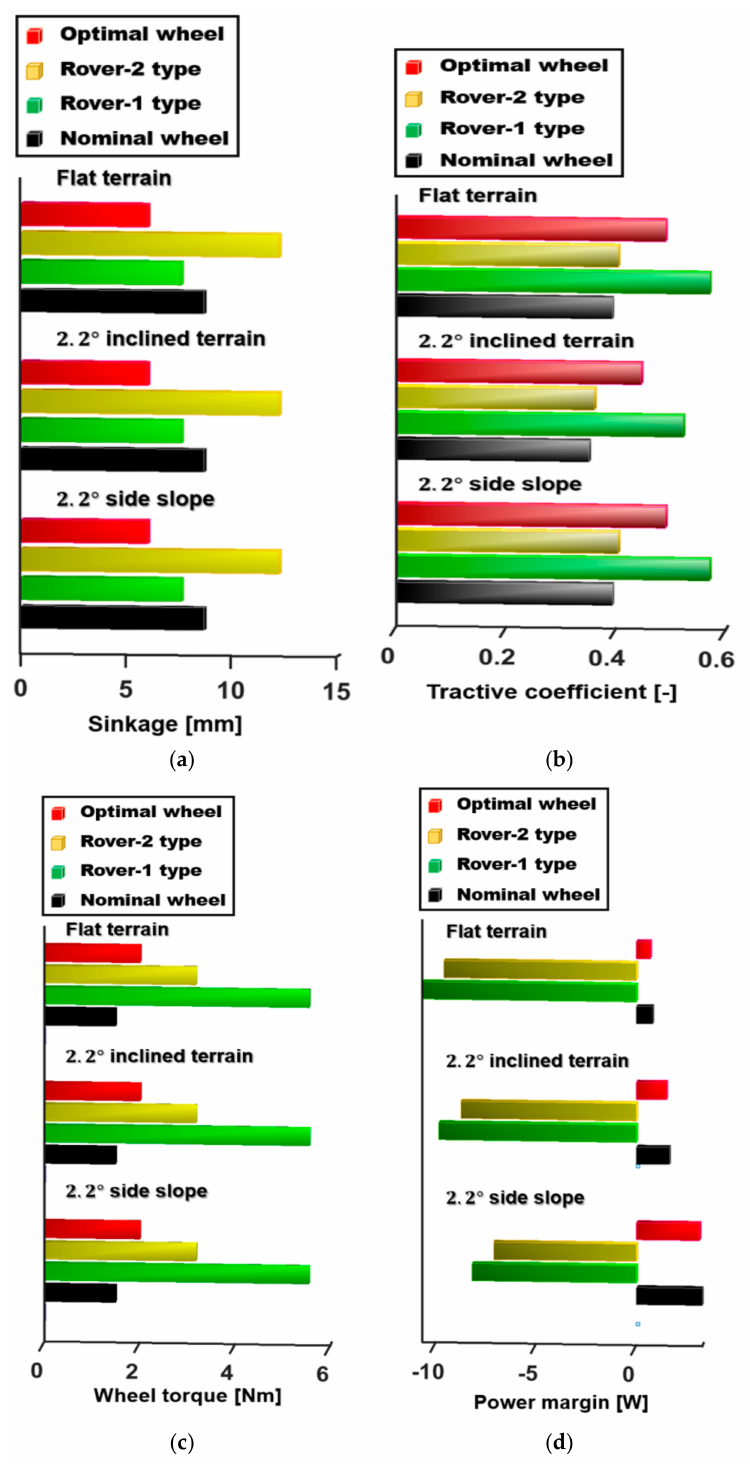
Figure 15. Simulation results from scenario-based dynamic analyses for three defined scenarios (flat deformable terrain, 2.2 ◦ longitudinal inclined deformable terrain, and 2.2 ◦ side slope deformable terrain) at landing site of latitude 44.12 ◦ N: ( a ) sinkage; ( b ) tractive coe ffi cient; ( c ) wheel torque; ( d ) power